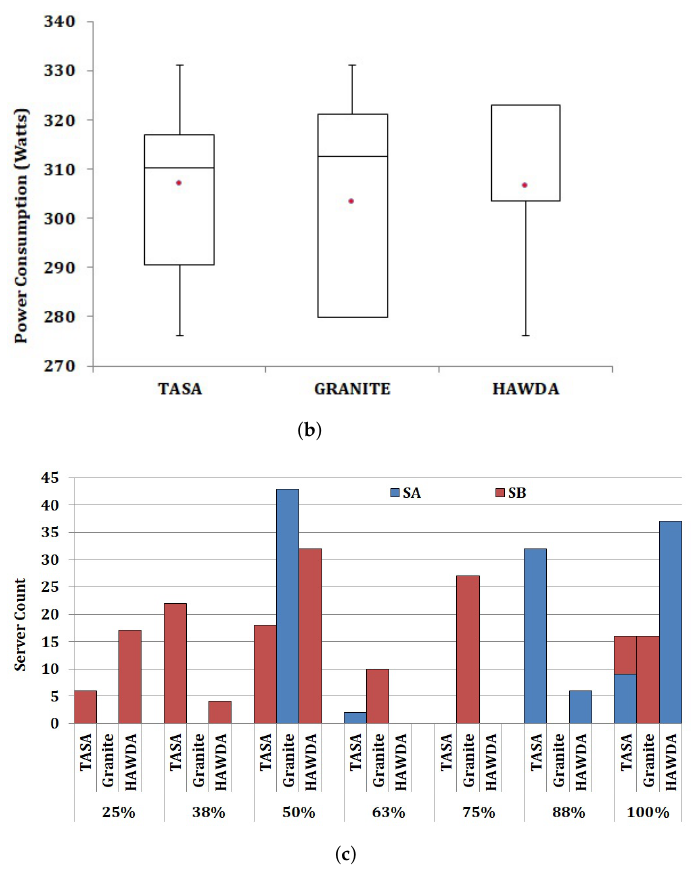
Figure 2. Outlet temperature, power consumption, and percentage utilization of servers on deploy- ment of all VM batches: ( a ) outlet temperature, ( b ) power consumption, and ( c ) percentage utilization of